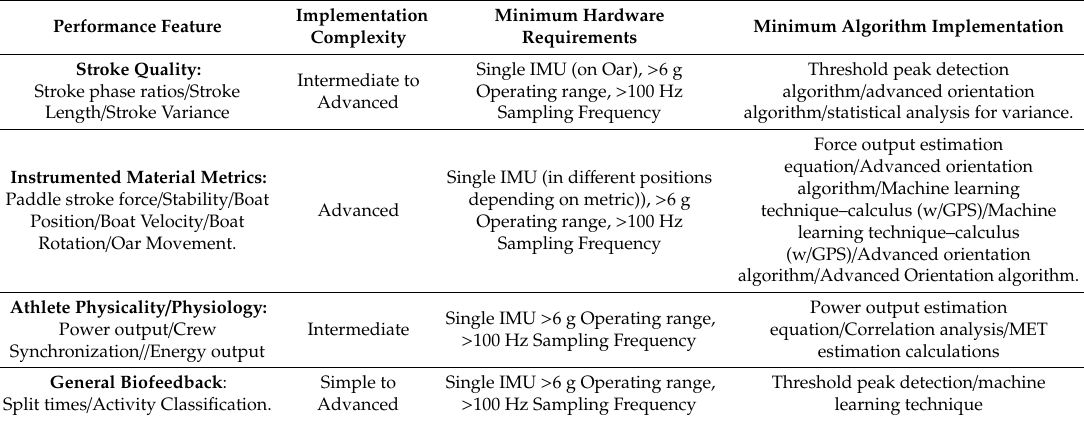
Figure 3. Operational guidelines for methodology design in rowing technology research. Table 7. Reference guide for technology selection when conducting future